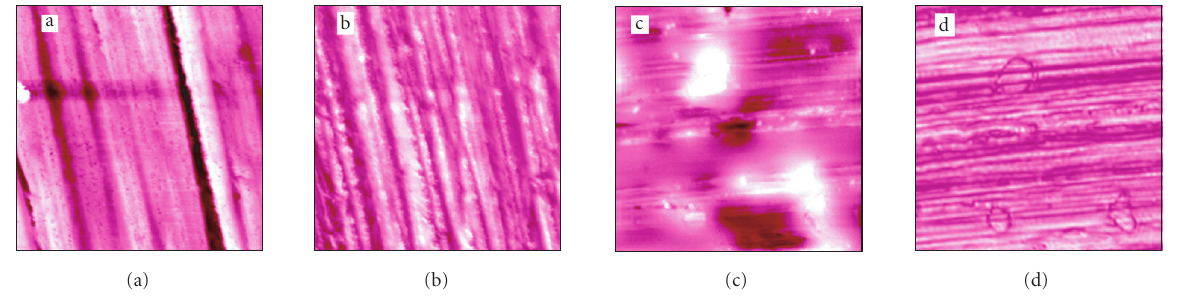
Figure 30: Simultaneous shear-force AFM (a) (10 μ m, Z range 1 μ m), (c) (Z range 600nm), and apertureless SNOM (b), (d) of an abraded cobalt alloy: (a) and (b) before, (c) and (d) after standard electrochemical load.